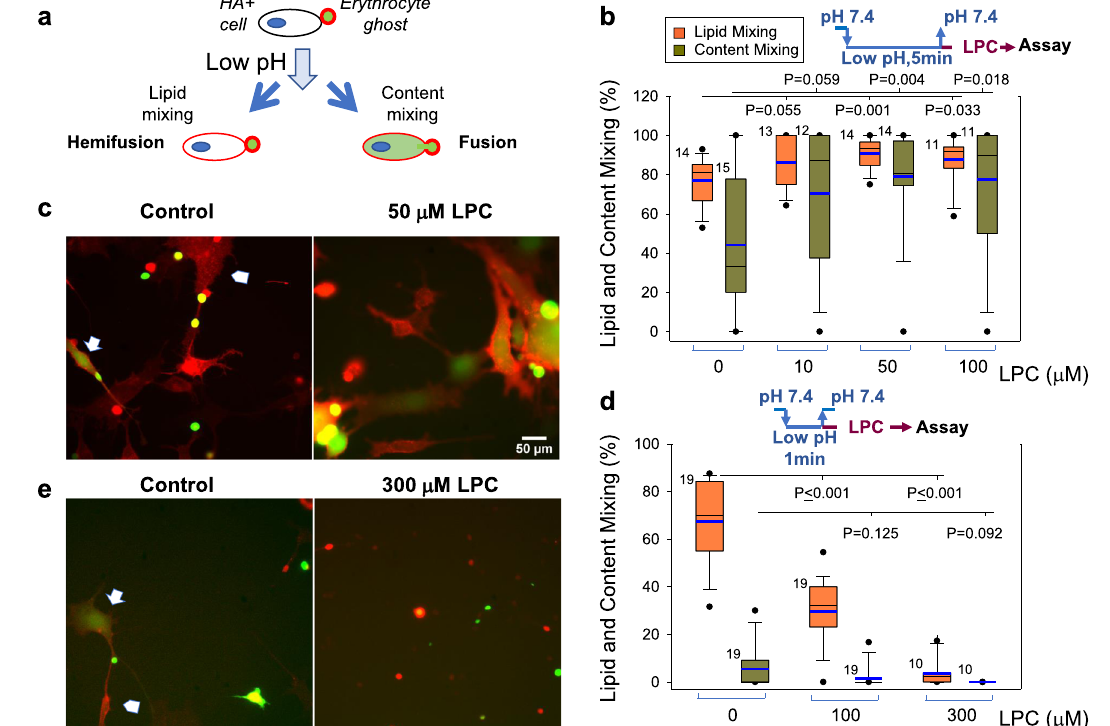
Fig. 4 Dependent on the time of application and concentration, LPC either promotes hemifusion-to-fusion transition or inhibits hemifusion stage in HA-mediated cell fusion. a Cartoon depicting in fl uenza hemagglutinin (HA)-mediated fusion assay. HA-expressing 3T3 fi broblasts with pre-bound erythrocytes that were labeled with both lipid and content probes were treated with a low pH pulse. Lipid mixing without content mixing and lipid- and content- mixing report hemifusion and fusion, respectively. b , c HA-cells with pre-bound erythrocytes were treated with a 5-min pulse of pH 5.0 medium at 22 °C. Immediately after the end of low pH pulse, we applied the PBS supplemented with different concentrations of LPC. d , e HA-cells with pre-bound erythrocytes were treated with a 1-min pulse of pH 5.0 medium at 22 °C. Immediately after the end of low pH pulse, we applied the PBS supplemented with different concentrations of lysophosphatidylcholine (LPC) at the room temperature. b , d Fusion was analyzed with fl uorescence microscopy 60 min after the low pH application. Content mixing (fusion) and lipid mixing (fusion plus hemifusion) were quanti fi ed as the ratios of the numbers of either content probe (carboxy fl uorescein)-labeled HA-cells or lipid probe (PKH26)-labeled HA-cells, respectively, to the total number of HA-cells. Both b and d present representative results in one of three independent cell preparations each. N , the number of randomly selected fi elds of view examined for each condition is indicated to the left of the box associated with that data. Box-and-whisker plots show median (center line), mean (blue line), 25 – 75th percentiles (box), 10 – 90th percentiles (whiskers), and 5 – 95th percentiles (solid circles). P -values were calculated using a two-tailed unpaired t -test. c , e Representative images for the experiments in B taken for control cells and for the cells treated with 50 μ M LPC ( c ) and for the experiments in d taken for the control cells and for the cells treated with 300 μ M LPC ( e ). Arrows mark examples of fusion: HA-cells that acquired from fused RBC both lipid (red)- and content (green) probes. Arrowheads mark examples of hemifusion: HA-cells that acquired from fused RBC only lipid (red) probes. Scale bar 50 μ